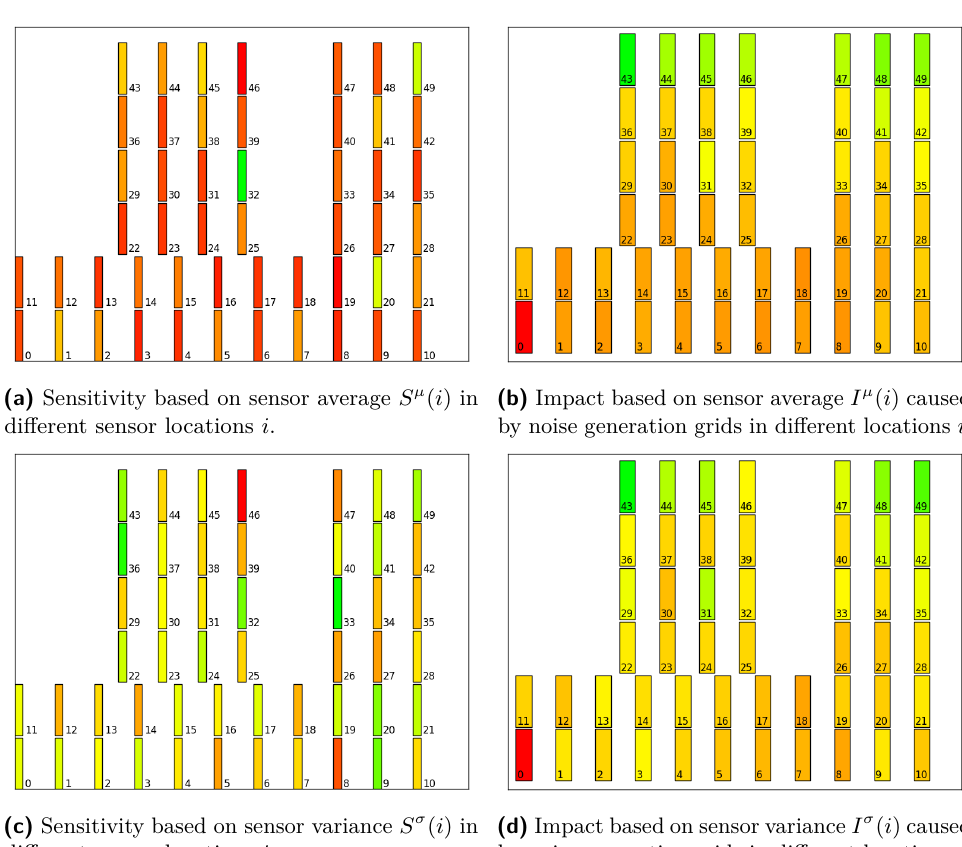
Figure 8: Influence of global placement of FF-based noise generators and TDC sensors evaluated and averaged over 1000 measurements on board A. Locations that are colored orange/red correspond to sensors that are more sensitive or noise generators that cause a higher impact respectively. Green colored locations are less sensitive or cause less